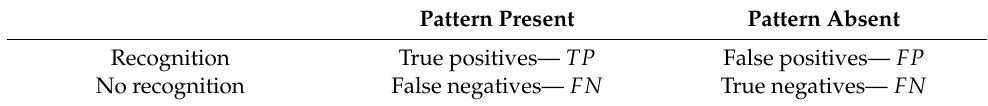
Table 2. Possible outcomes when a predictive model is applied to an observation in a confusion Table 2. Monitored variables in the simulated dataset.